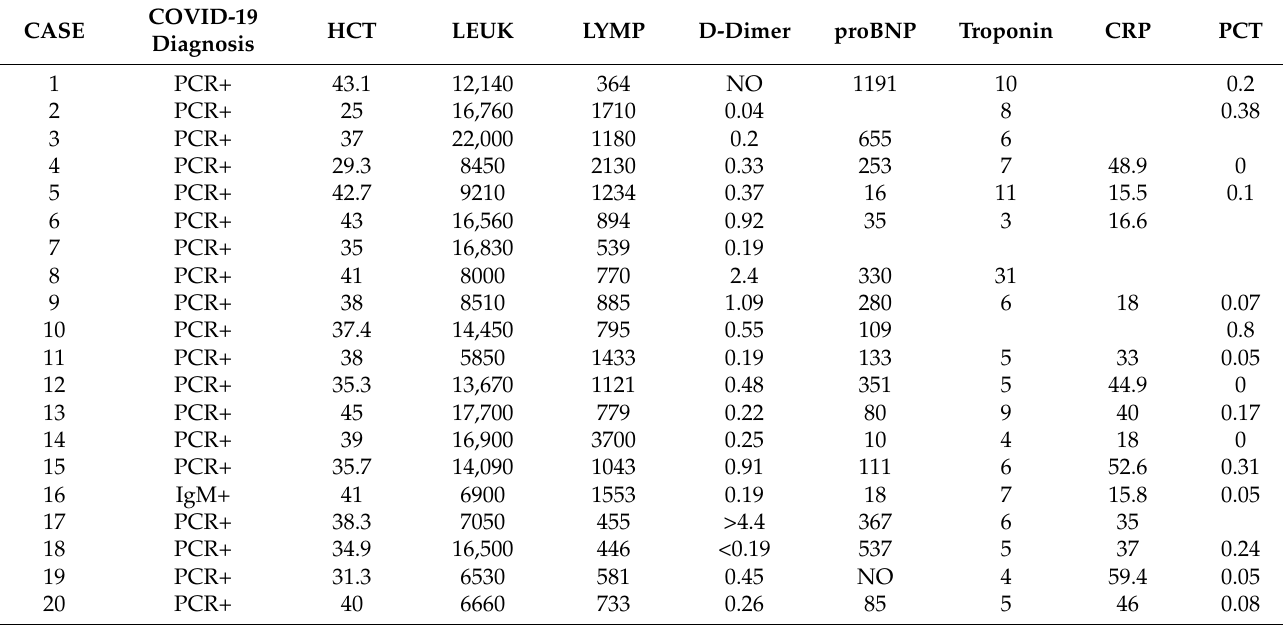
Table 2. Biochemical data at